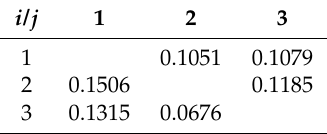
Table 3. Values δ T obtained by cross-testing of T ξ model. Mean value δ L = 0.0757.